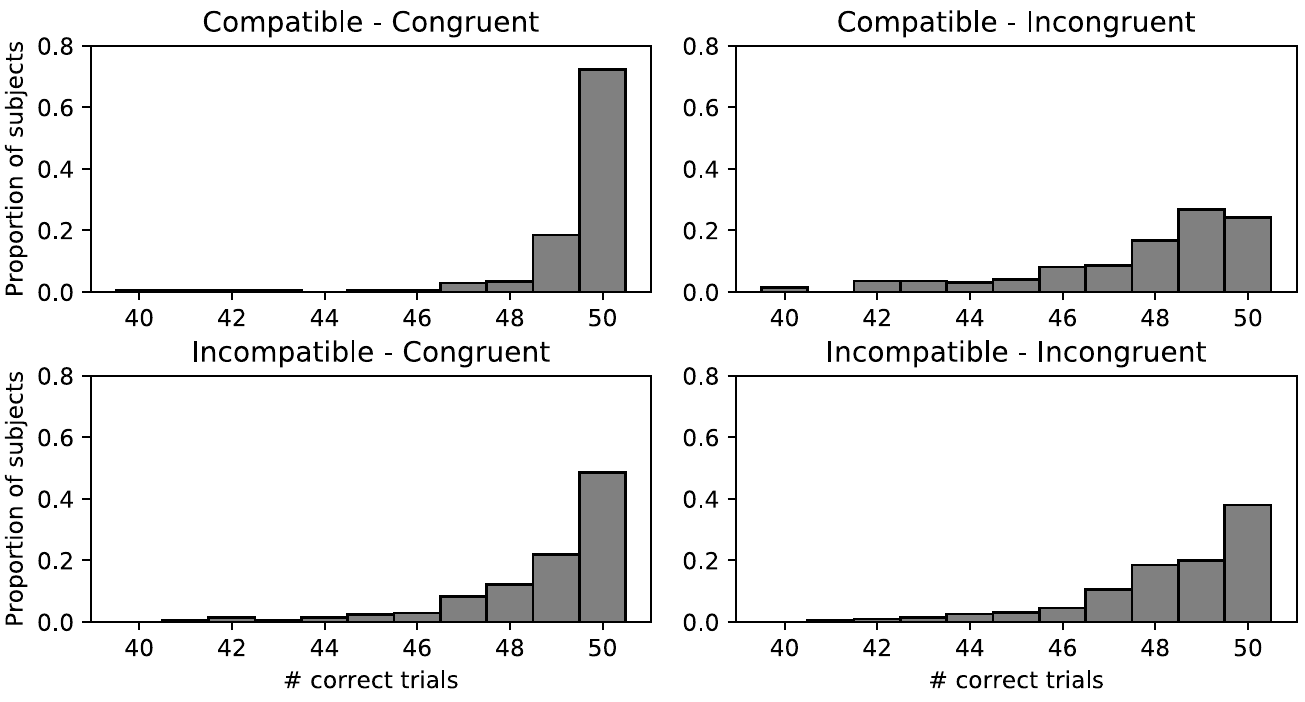
Fig 1. Histograms of task accuracy in each of the experimental conditions during Experiment 3. A large proportion of participants achieved perfect accuracy (50 correct trials out of 50), with most performing close to ceiling, suggesting the Flanker task may not have been difficult enough.